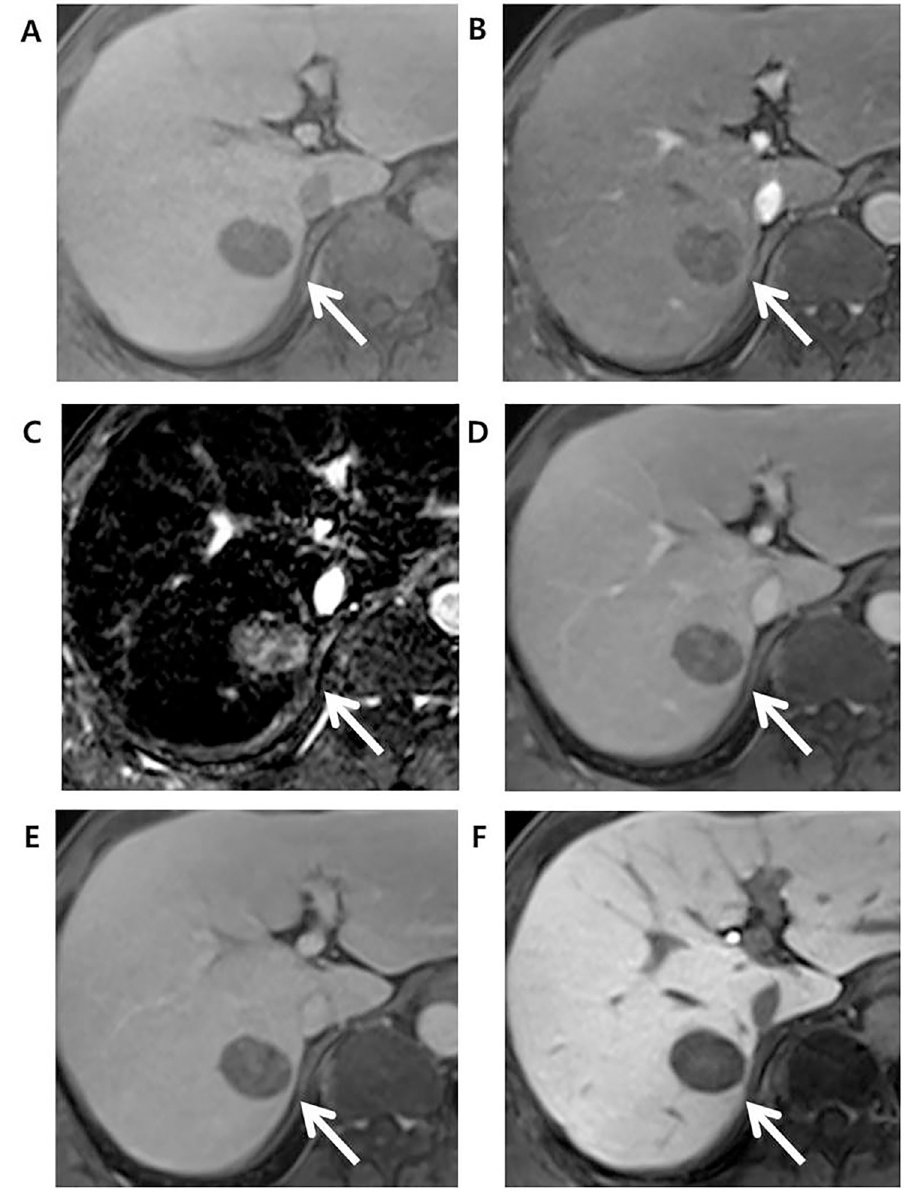
Fig 2. Edmonson grade 3 HCC in 49-year-old male with underlying B-viral chronic hepatitis. Compared to the (A) axial pre-contrast phase, the (B) late arterial phase (AP), and (D) portal venous phase (PVP) images after gadoxetate administration showed a 30mm-sized liver mass (arrow) in segment 7 (S7) of the liver with no nonrim arterial hyperenhancement in the late arterial phase but washout in the portal venous phase. Initially, this hepatic observation was categorized as LR-4. (C) The arterial subtraction image, however, showed homogeneous enhancement compared to the normal liver parenchyma. This hepatic observation was thus recategorized as LR-5 based on the arterial subtraction image. (E) Delayed phase and (F) hepatobiliary (HBP) phase images showed decreased signal intensity in the hepatic observation compared to liver parenchyma.